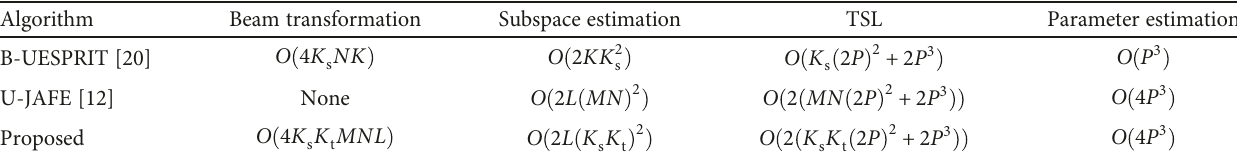
Table 1: Comparison of computational